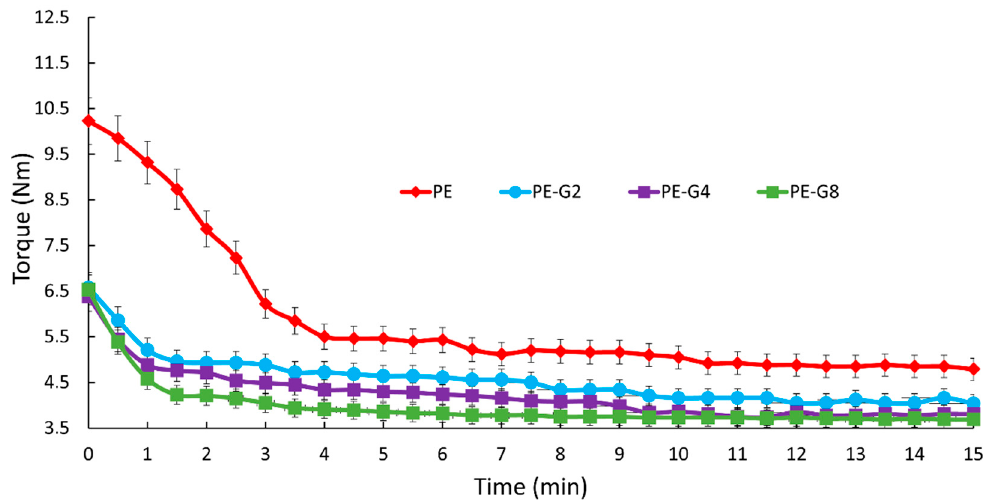
Figure 2. Torque vs. time for PE, PE-G2, PE-G4, and PE-G8 samples. The presence of graphite ball-milled for 8 h further lowered the torque value to 3.7 Nm (after 15 min of mixing). In general, the torque progressively decreased. The more the ball-milled graphite, the longer the graphite treatment time. The torques of these samples are shown in the order: